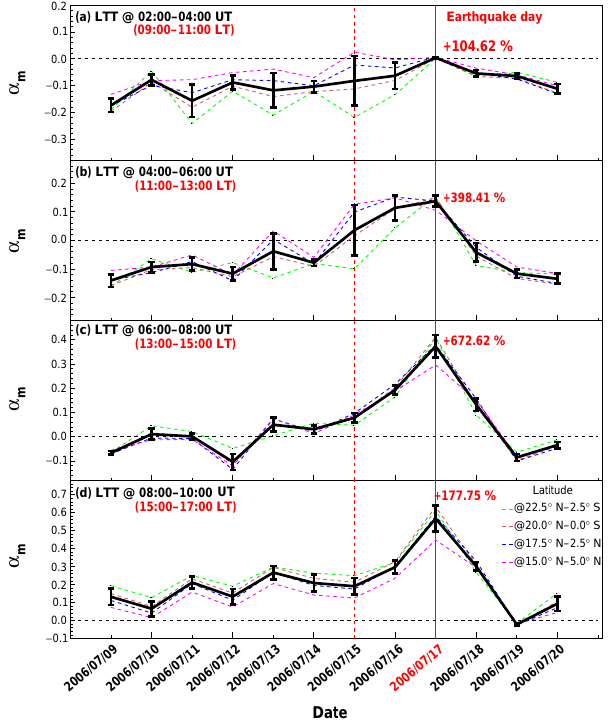
Figure 6. The asymmetry of LTT plots. (a–d) The temporal distri- bution of asymmetry coefficient α m of LTT plots in Fig. 5 during four continuous time periods, i.e., 02:00–04:00, 04:00–06:00UT, 06:00–08:00 and 08:00–10:00UT, from 9 to 20 July 2006. The green, brown, blue and magenta dashed lines represent the distri- bution of α m of LTT plots at four different symmetric latitude pairs with respect to the magnetic equator, i.e., 22.5 ◦ N–2.5 ◦ S, 20.0 ◦ N– 0.0 ◦ S, 17.5–2.5 ◦ N and 15.0–5.0 ◦ N, and the black solid line rep- resents the mean value of that of four different symmetric latitude pairs with respect to the magnetic equator. The earthquake day and day 2 before the earthquake are represented by red vertical solid and dashed lines,